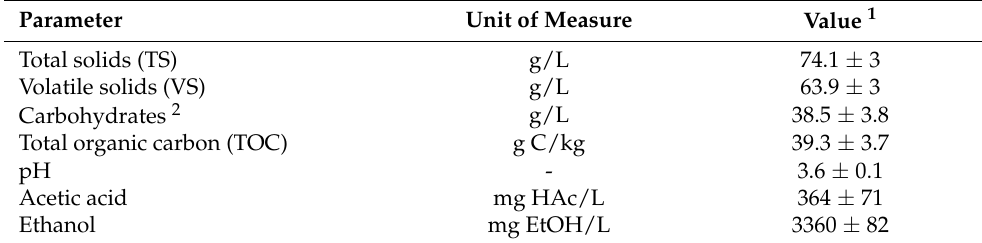
Table 1. Characterization of the CW used as the substrate in Stage